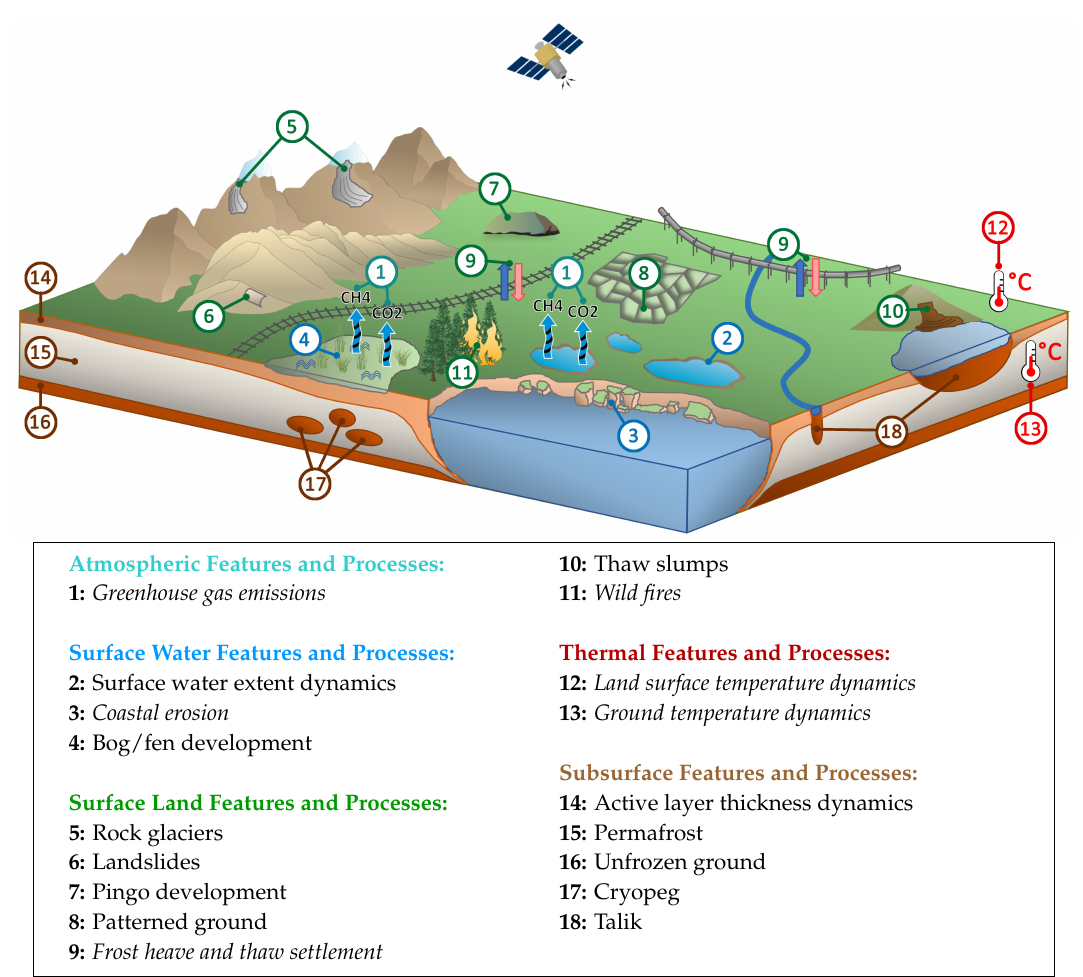
Figure 1. The info-graphic illustrates a variety of common permafrost related features and processes. Processes are hereby written in italics. Several symbols, which were used to generate the infographic, were adopted or modified according to courtesy of the Integration and Application Network, University of Maryland Center for Environmental Science